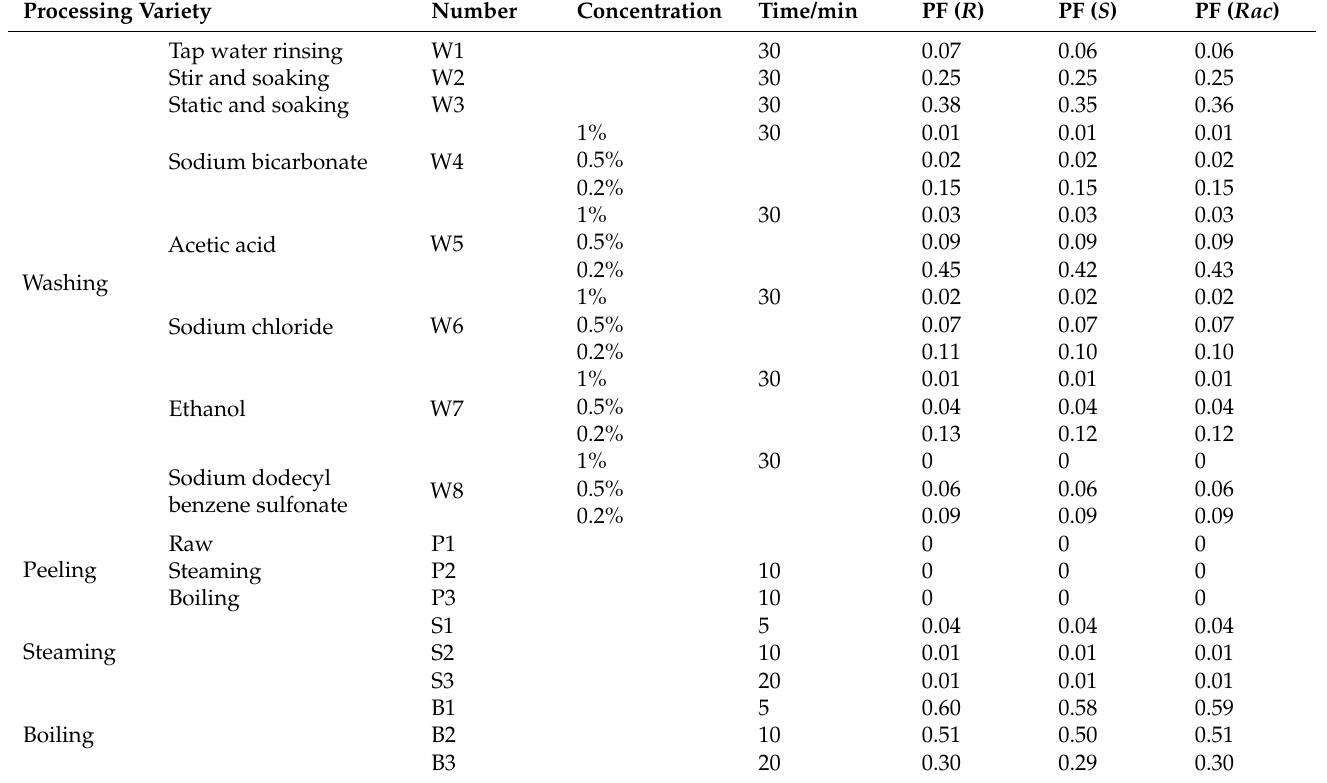
Table 4. PFs of penthiopyrad in eggplant samples after different processing